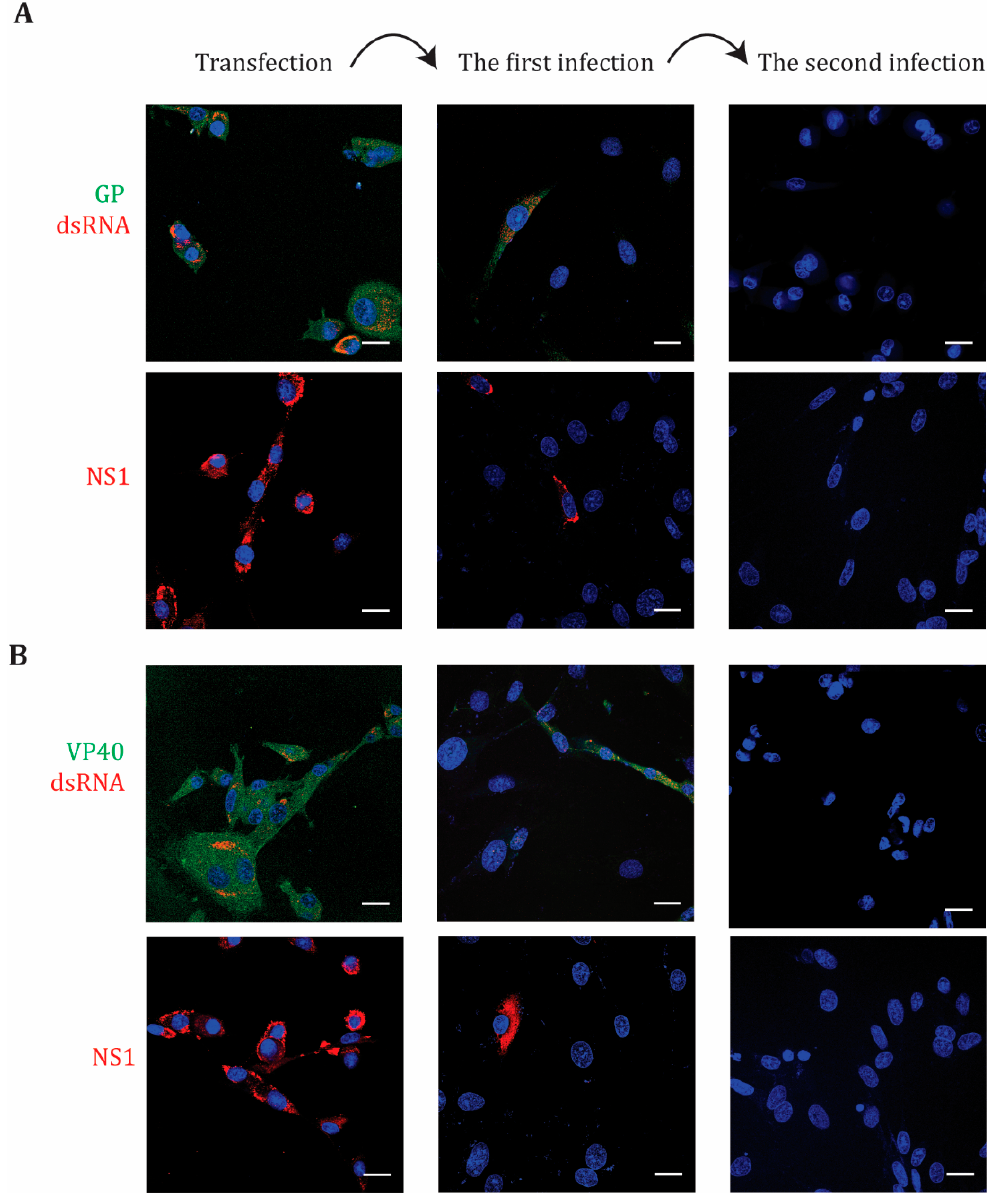
Figure 6. Immunofluorescence labeling of BHK-21 C-prM-E cells after transfection with the KUNV replicons expressing EBOV GP or VP40 proteins ( A , B ), respectively, followed by two cycles of RVP infections of BHK-21 cells. The cells were visualized with the antibodies anti-EBOV GP (green), EBOV VP40 (green) ( A ) and ( B ), respectively, and the antibodies anti-dsRNA (red) and KUNV NS1 (red). The nucleus was counterstained with DAPI (blue). Bar scales represent 20 µm.